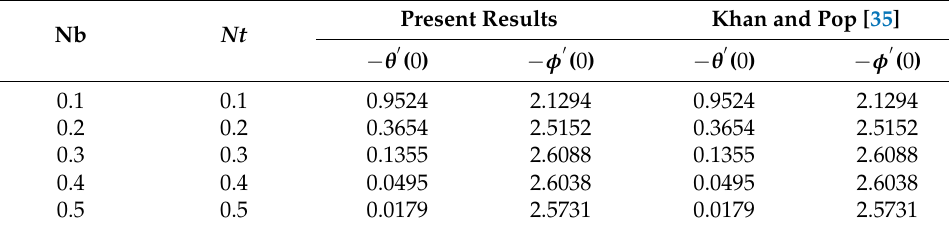
Table 1. Contrast of M = 1, and − φ (cid:48) ( 0 ) against M , R , λ 1 , Gr , Gc , γ 1 = 0 with Pr, Le = 10 and Ω = 90 ◦ .